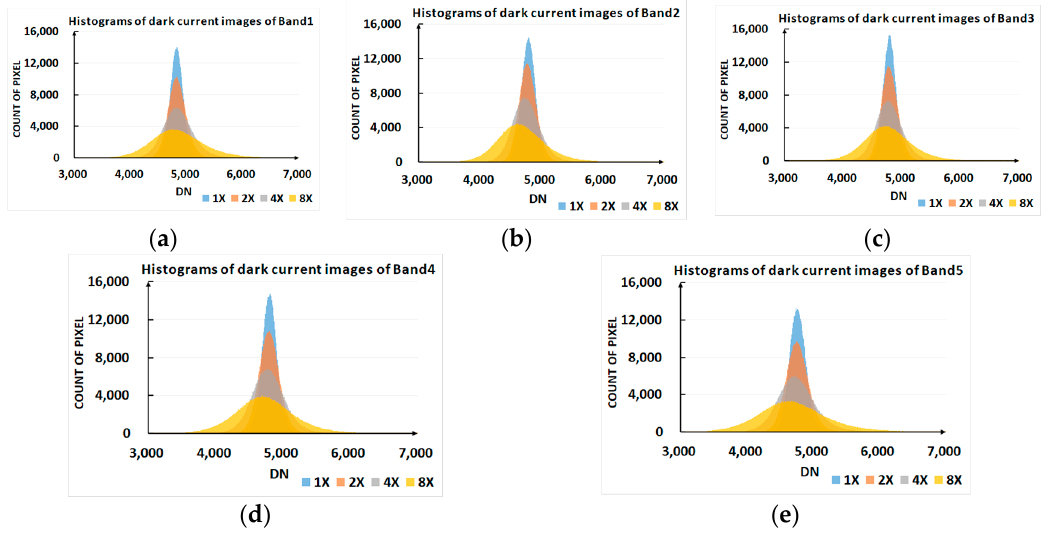
Figure 6. Histograms of dark current images at different gain settings for various bands: ( a ) Band1; ( b ) Band2; ( c ) Band3; ( d ) Band4; ( e ) Band5.